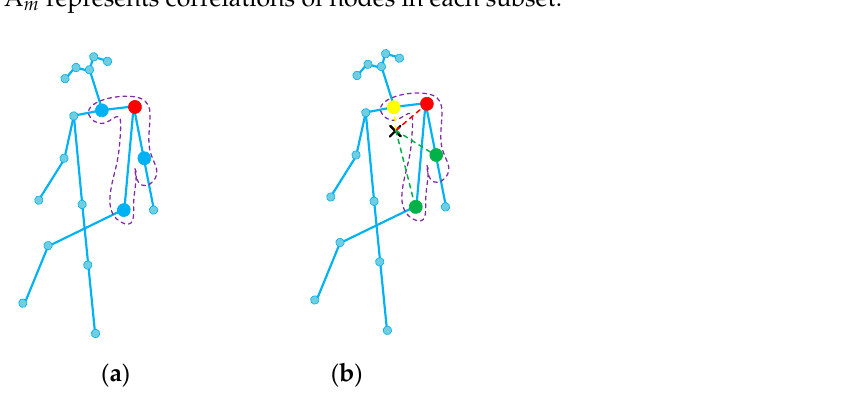
Figure 2. The spatial configuration partitioning strategy for partitioning the neighbor set. ( a ) Input skeleton of a person in a frame. The neighbor nodes and their root node (colored in red) are circled with a dashed line. ( b ) The nodes are labeled according to their distances from the skeleton gravity center (black cross) compared with that of the root node. The yellow ones represent centripetal nodes that have a shorter distance. The green ones represent centrifugal nodes that have a longer distance than the root node.